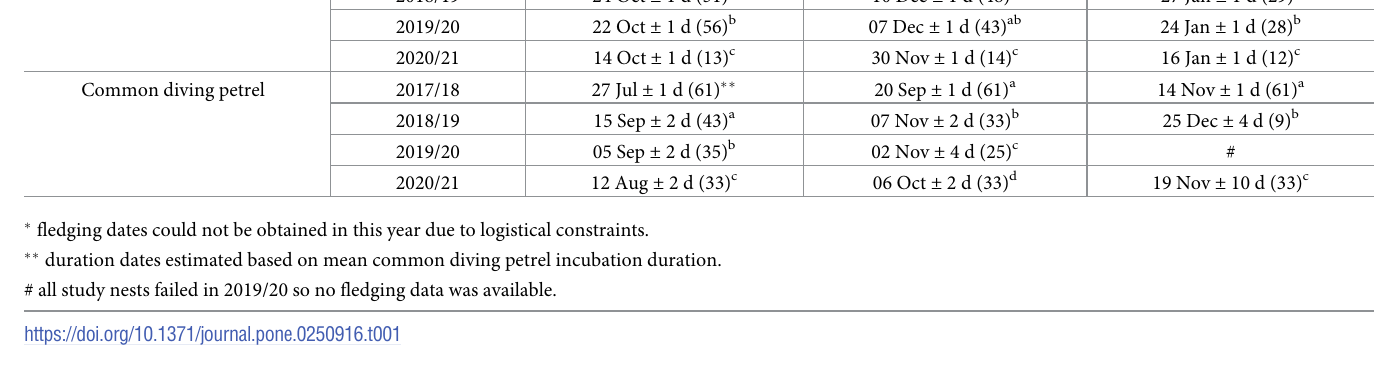
years at, 47 ± 1 d and 50 ± 1 d, respectively.